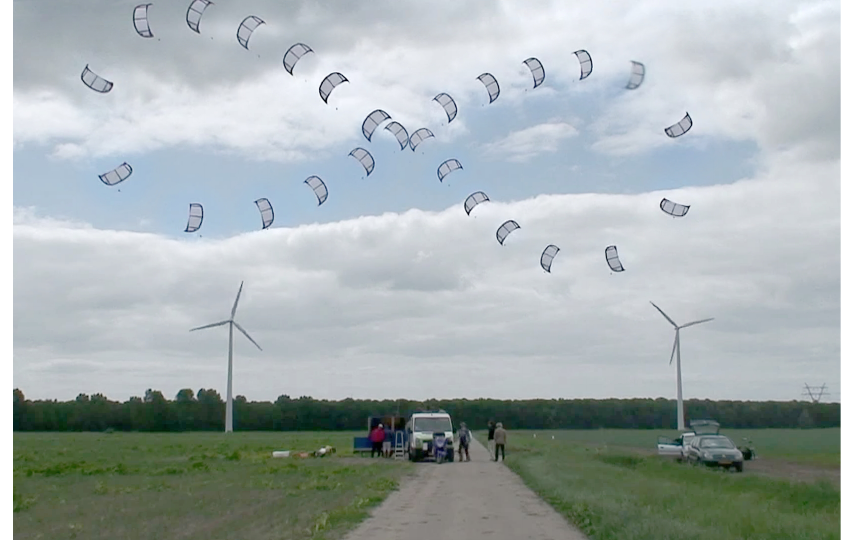
Figure 2. Composite photo of a crosswind figure-of-eight maneuver ( ∆ t = 1 s) of a tube kite with 25 m 2 wing surface area